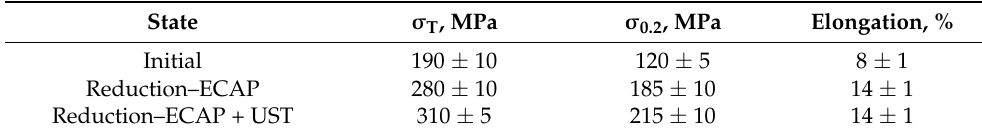
Figure 4. Hardening curves of Mg-Al-Zn alloy. Table 3. Mechanical properties of Mg-Al-Zn